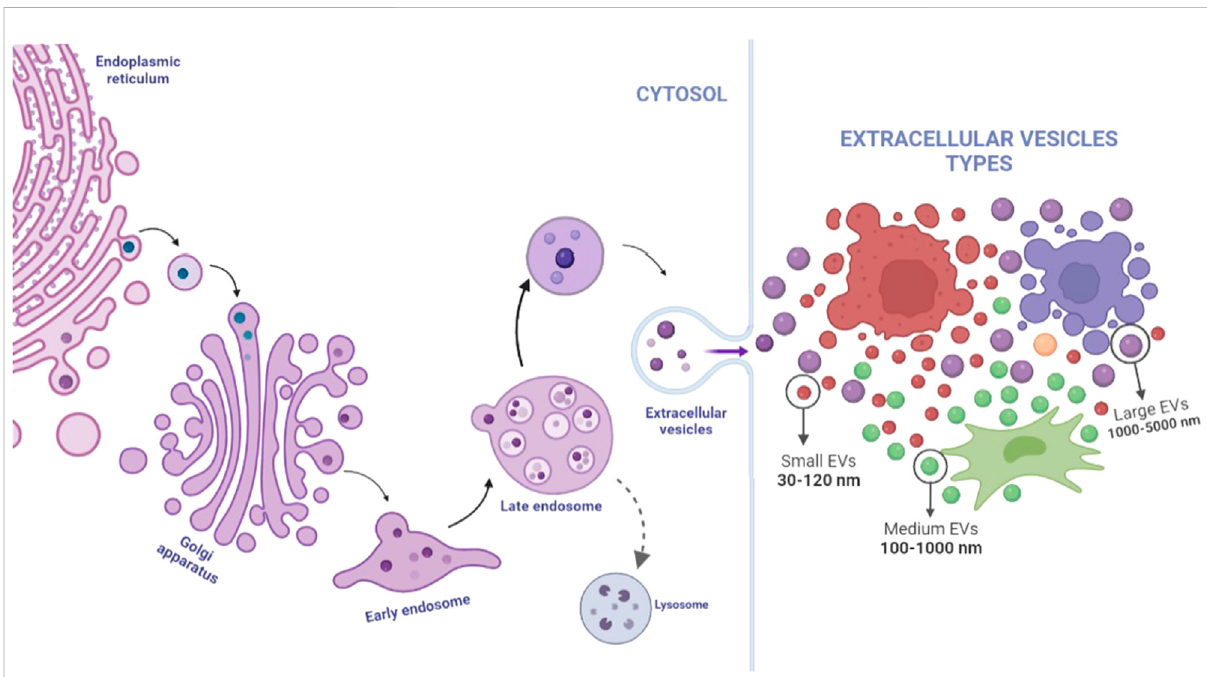
FIGURE 2 Extracellular vesiclesareagenericnameformanykindsofvesicles releasedbycells;theiroriginandsizearedeterminantsintheirclassi fi cation. Exosomes present size between 30 and 120 nm, and an endosome being initially formed in cell cytosol from the early endosomes until late endosome release by the in fl uence of speci fi c proteins such as ESCRT and Rab family and could be excreted by any type of cells, including MSCs, tumor cells, and, even, immune cells. Microvesicles could present size within the range of 100 – 1,000 nm and could be released by any cells, whereas apoptotic bodies are the biggest group, excreted only for apoptotic cells. Image created on